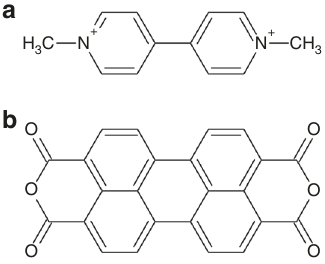
Fig. 1 Molecular structures of the charge carrier and the host